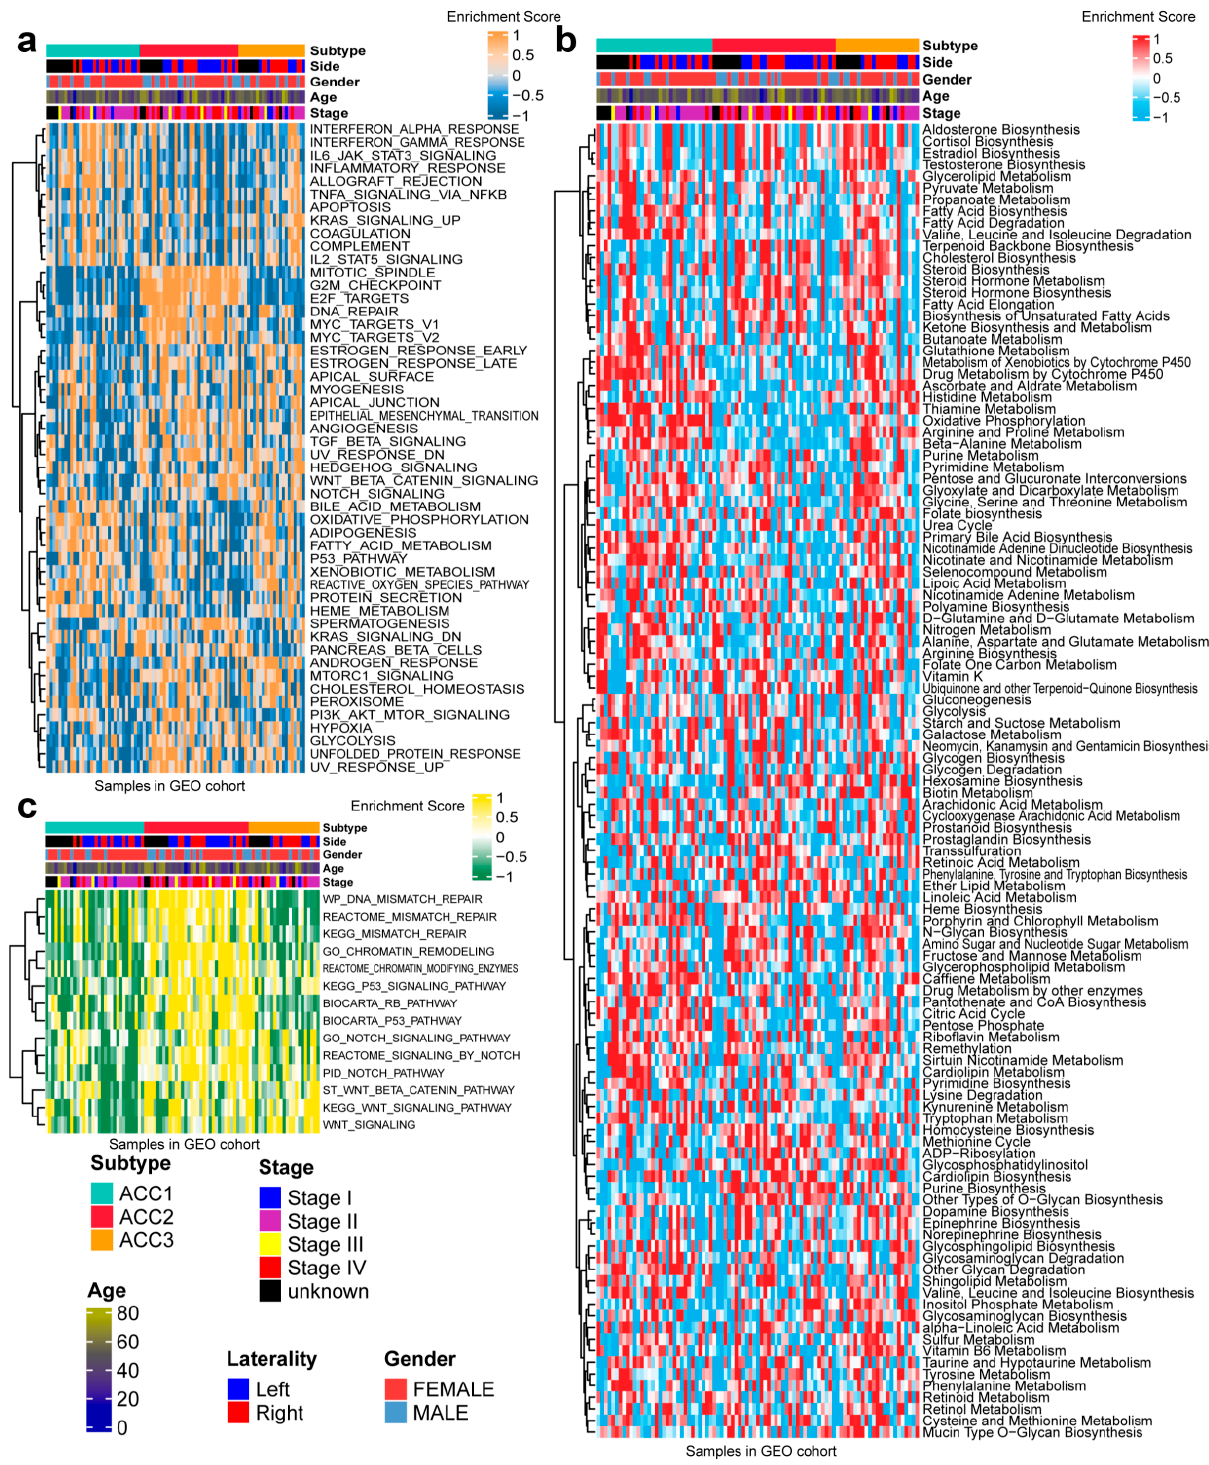
Figure 8. Differential activity of tumor-associated pathways across three ACCs subtypes in GEO cohort. ( a ) Heatmap of 50 differentially activated HALLMARK pathways. ( b ) Heatmap of 100 pathways related to metabolism of ACCs. ( c ) Heatmap of DNA repair pathways.